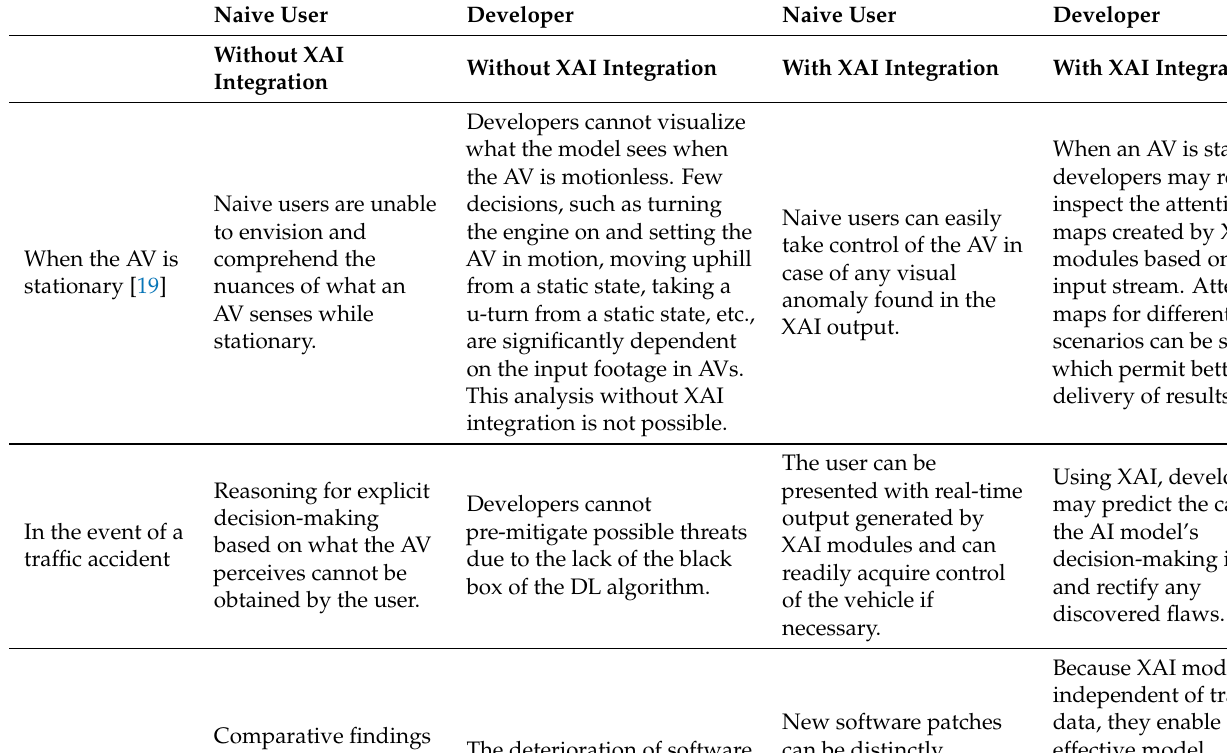
Table 3. A few scenarios with and without XAI-integrated modules in AVs are